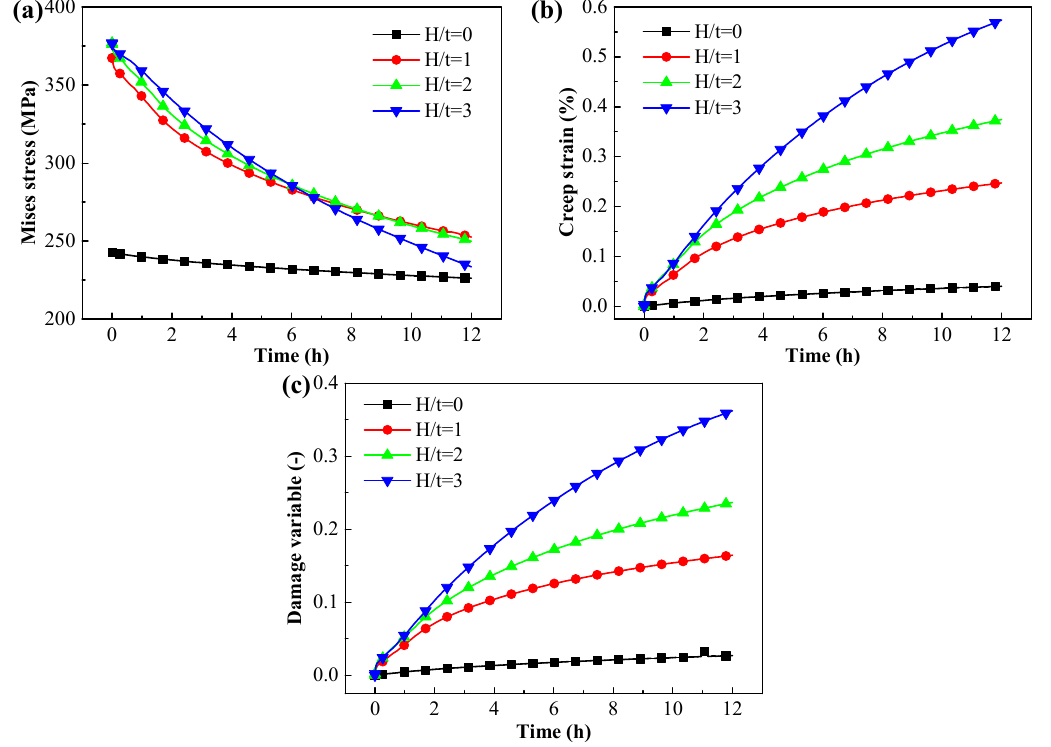
Figure 16. Evolutions of ( a ) Mises stress, ( b ) creep strain, and ( c ) damage variable on feature point of AA7050 ribbed panels.